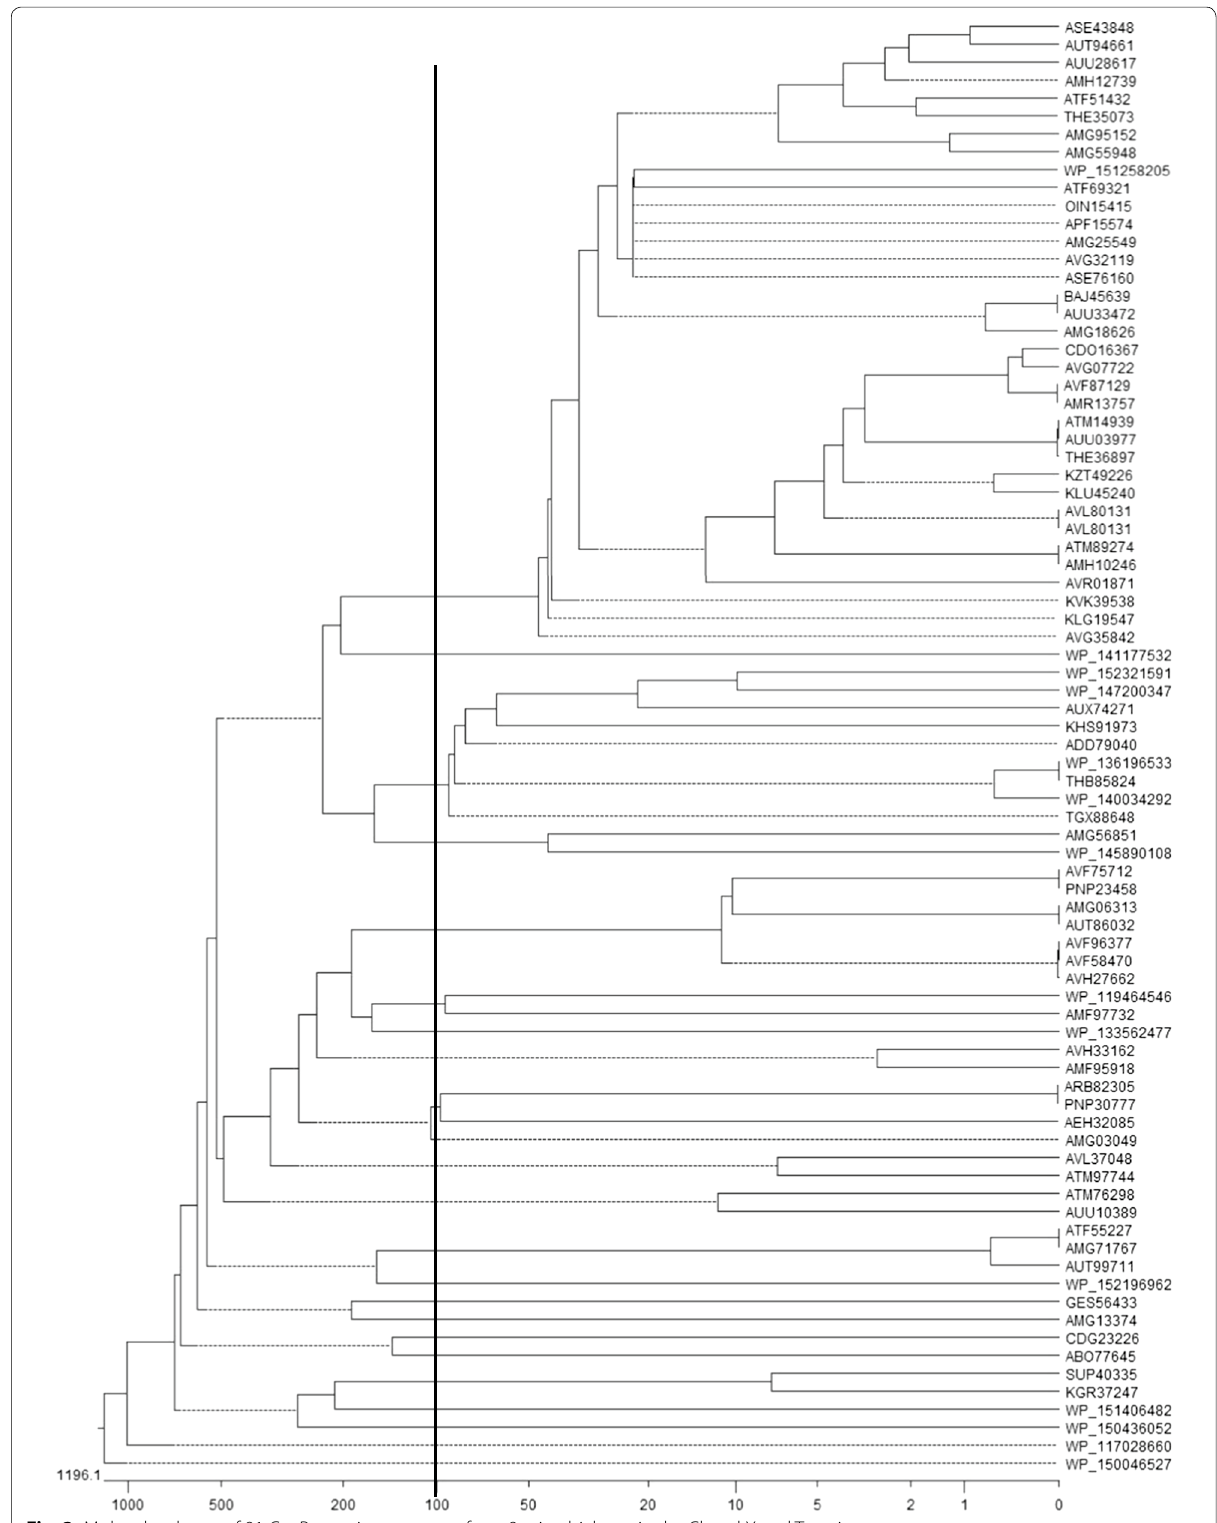
Fig. 3 Molecular cluster of 81 CpxP protein sequences from 8 microbial species by Clustal X and